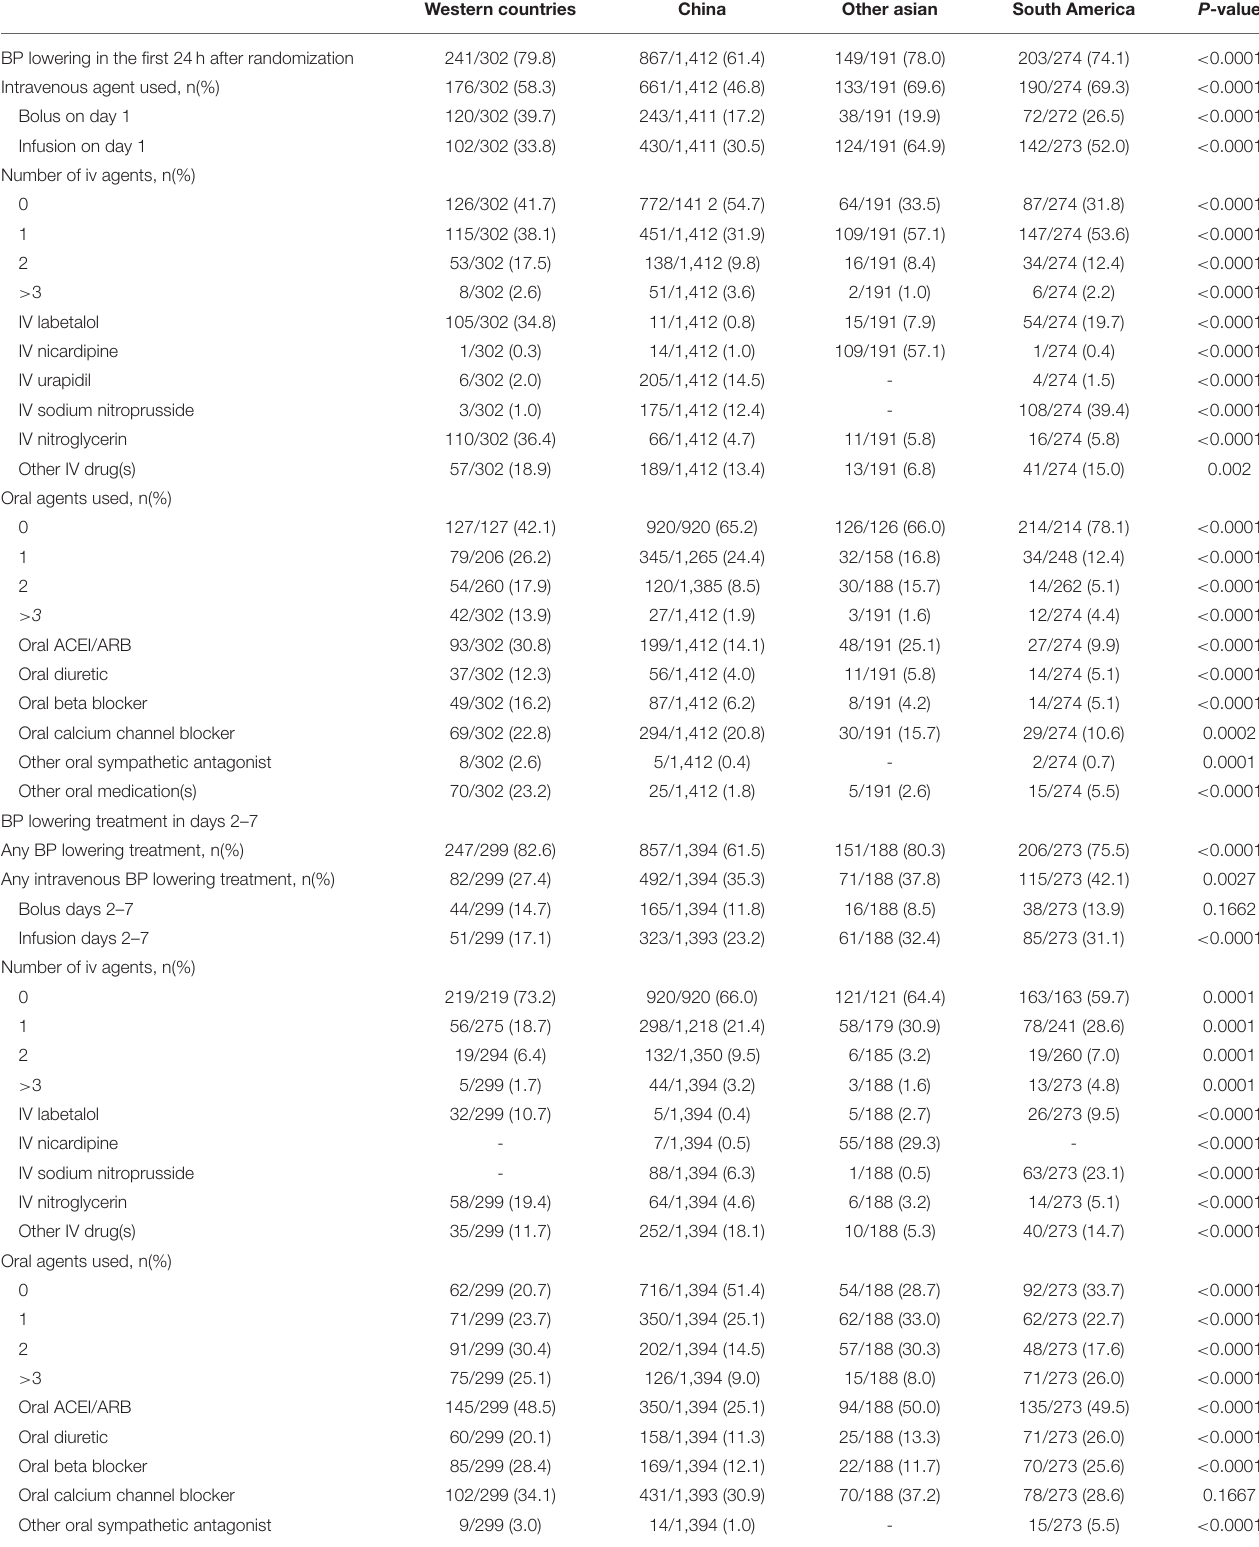
TABLE 2 | BP-lowering treatment by region in